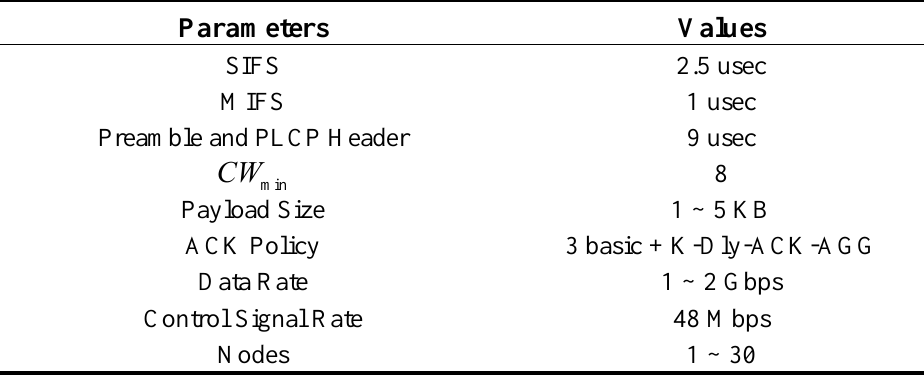
Table 2. Parameters for Performance